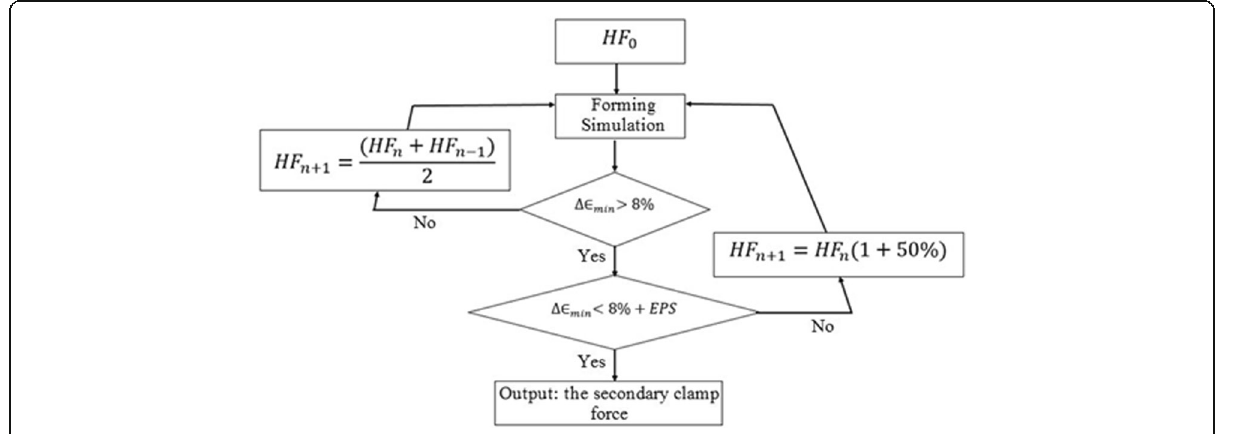
Fig. 6 Algorithm of the secondary blank holder force (Löytty et al. 2016)